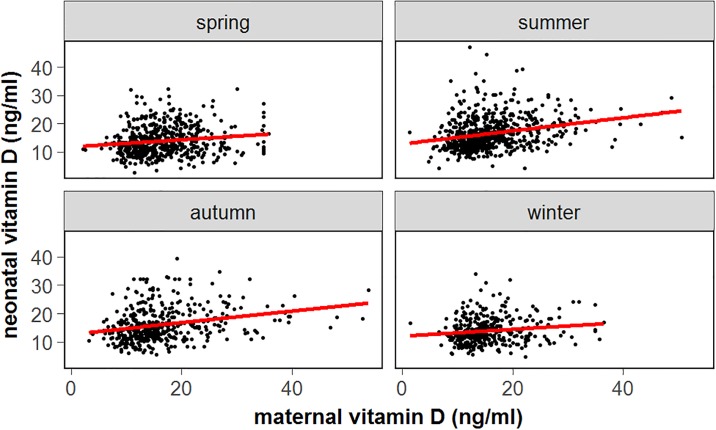
Association between neonatal cord blood 25(OH)D level and maternal 25(OH)D level during pregnancy distributed by birth season.